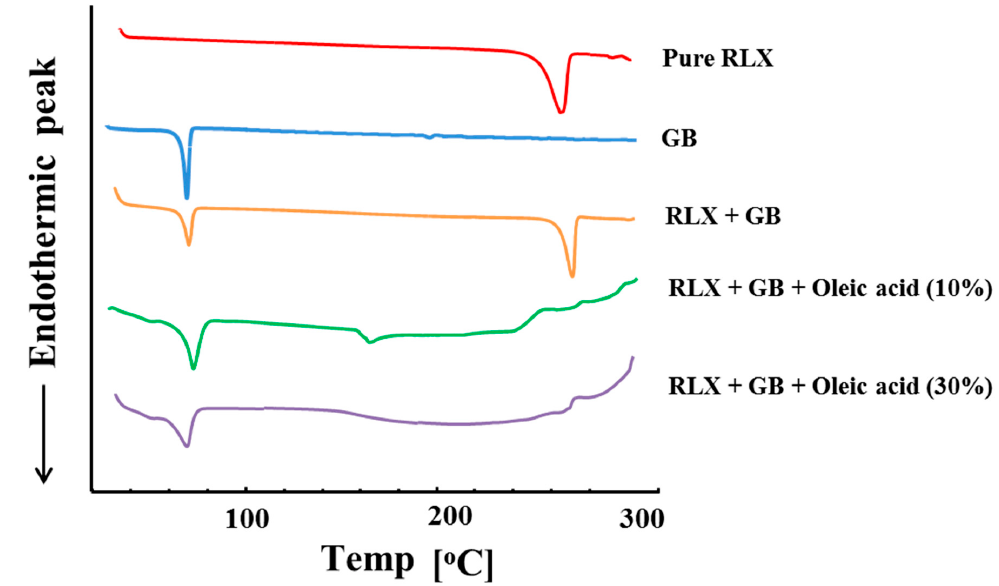
Figure 4. Di ff erential scanning calorimetry (DSC) thermograms of the physical mixture of ingredients Figure 4. Differential scanning calorimetry (DSC) thermograms of the physical mixture of used in the NLCs. GB: glyceryl behenate; RLX: raloxifene ingredients used in the NLCs. GB: glyceryl behenate; RLX: raloxifene hydrochloride.